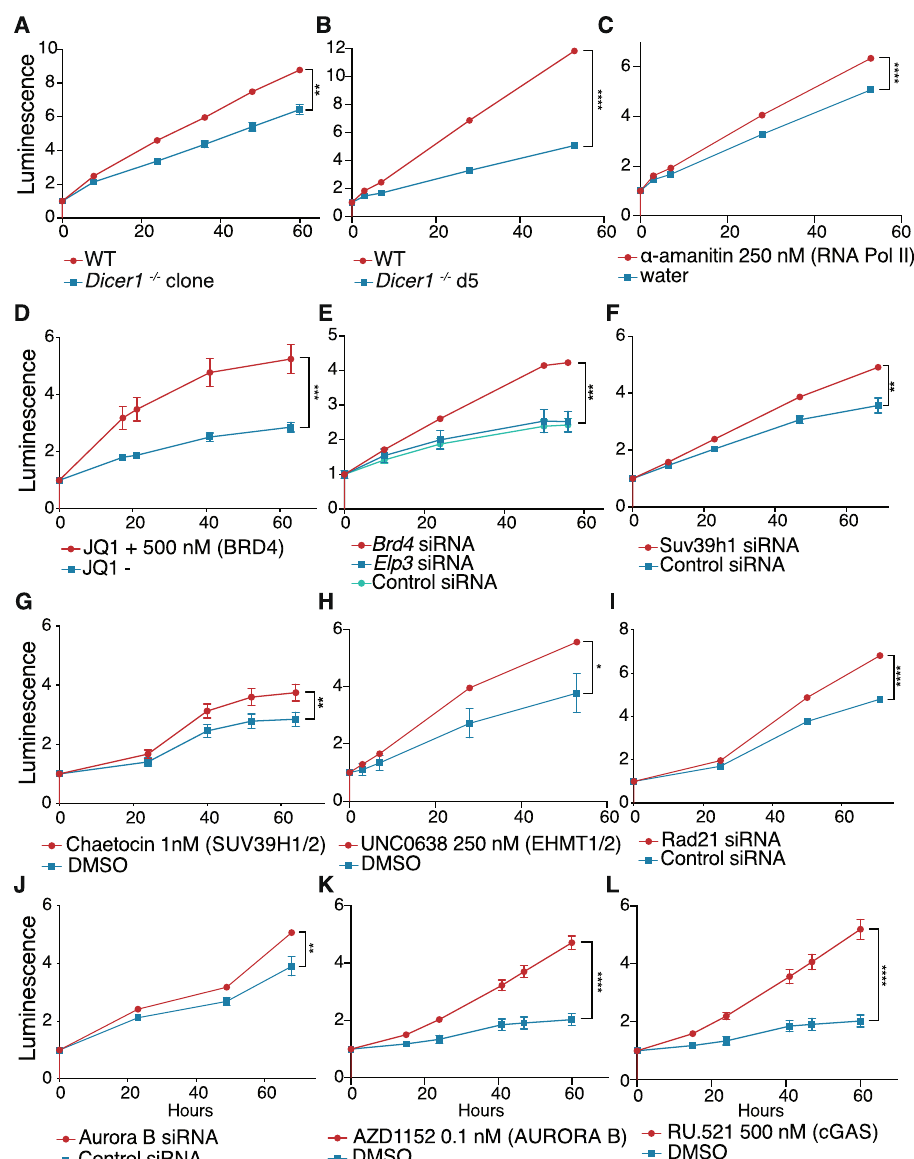
Fig. 3 Rescue of Dicer1 − / − mESCs with siRNA and with small molecules targeting suppressors. A , B MT proliferation and viability assay of uninduced wild type, compared with either Dicer1 − / − clones A or Dicer1 − / − induced cells over days 4 – 7 B . Dicer1 − / − mESCs have a strong viability defect. C – L MT assays reveal that the proliferation and viability defect of Dicer1 − / − induced cells over days 4 – 7 was rescued by targeting RNA Pol II with α -amanitin C , BRD4 with JQ1 D , Brd4 or Elp3 with siRNAs E , Suv39h1 with siRNAs F , SUV39h1/2 with the inhibitor chaetocin G , EHMT1/2 with the inhibitor UNC0638 H , Rad21 with siRNAs I , Aurora B with siRNAs J , AURORA B with the inhibitor AZD1152 K , or cGAS with the inhibitor RU.521 L . Luminescence is plotted over time (hours) after addition of pre-luminescent metabolite at t0. DMSO was used for small molecule delivery and slightly inhibited growth of untreated controls. One representative experiment is plotted in each panel ( N = 3 independent biological experiments), errors represent SEM, but may be smaller than points. **** − p -value < 0.0001, *** − p -value between 0.0001 and 0.001, ** − p -value between 0.001 and 0.01, * − p -value between 0.01 and 0.05, two-sided t -test of the fi nal timepoints of replicate experiments. Source Data are provided in the Source Data fi pericentromere, and is thought to recruit the chromosome pas- senger complex, comprising AURORA B kinase, SHUGOSHIN 1, phorylates members of the NDC80 complex 62 and centromeric H3K9me3 methyltransferases Suv39h1/2 , cohesin 63,64 . Both inhibition 65 and overexpression of AURORA B 66 leads to chromosome segregation defects. RAD21 is a core Ehmt1(GLP) , and Ehmt2(G9a) , were also weak suppressors of component of the cohesin complex that confers sister chromatid Dicer1 − / − viability defects (Fig. 2A – C). Targeting Suv39h1 with attachment during mitosis and is maintained speci fi cally at the siRNA (Fig. 3F) and sgRNA (Fig. S7K) signi fi cantly alleviated the centromere until anaphase 67 . Targeting either of these genes with Dicer1 − / − viability defect, as did the Suv39h1 inhibitor chaetocin 60 (Fig. 3G) and the Ehmt1/2 inhibitor UNC0638 61 siRNAs ameliorated the proliferation defects of Dicer1 − / − cells (Fig. 3I and J), as did targeting AURORA B with the (Fig. 3H). The majority of H3K9me2/3 is found at the